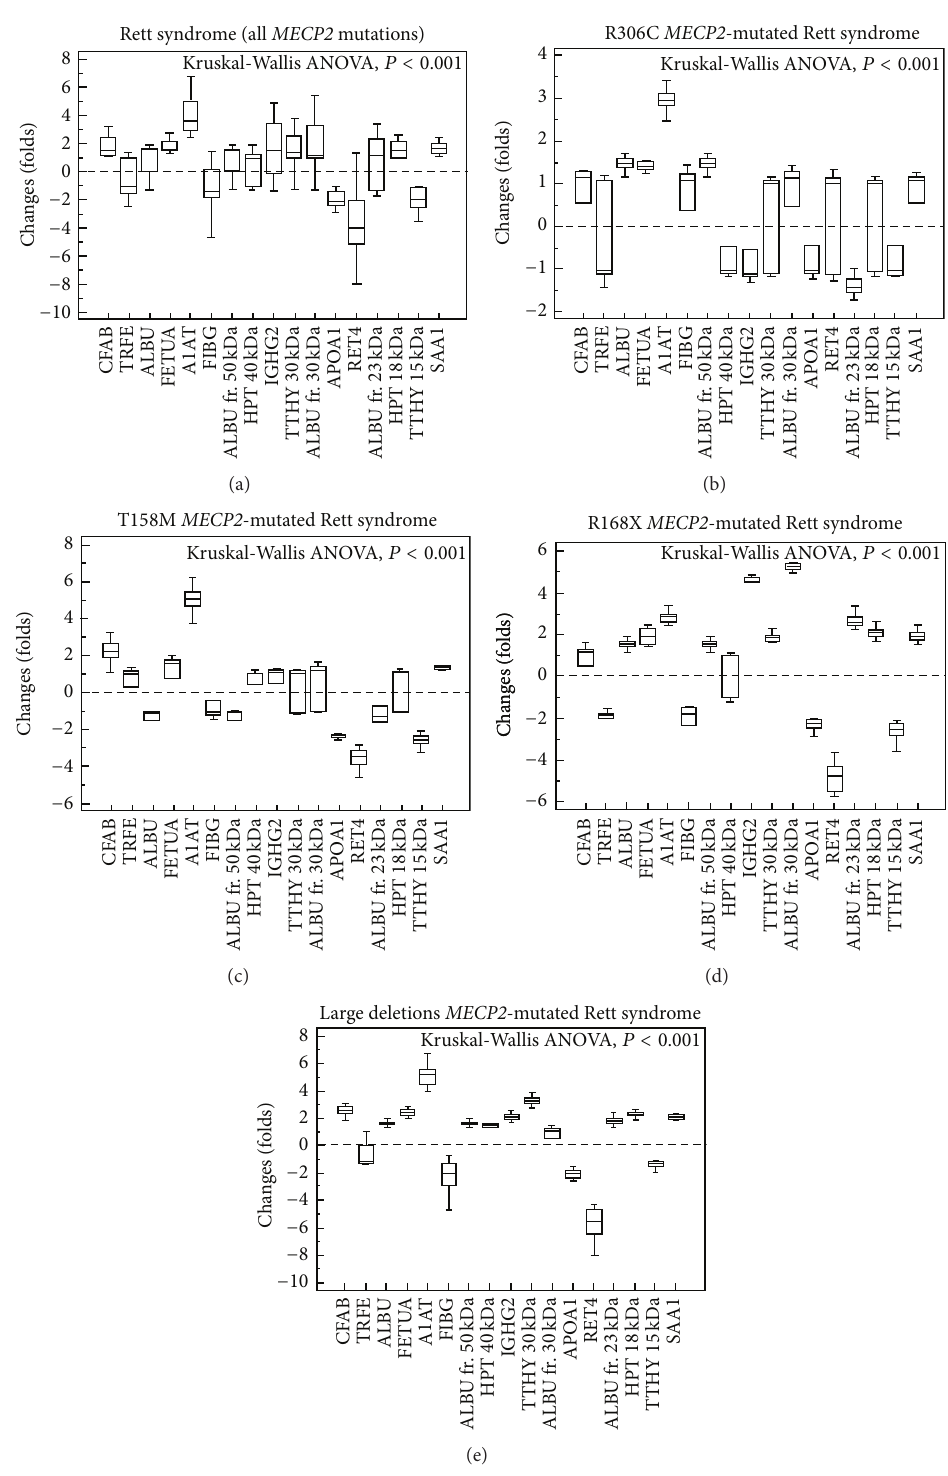
Figure 2: Plasma proteins expression as a function of MECP2 mutations in girls with classical Rett syndrome. (a) All MECP2 mutations, (b) R306C mutation (milder form), (c) T158M mutation (intermediate severity), (d) and (e) correspond to R168X and large deletions (severe forms), respectively. Data are compared to matched healthy controls and expressed as box-and-whiskers plots. Results of Kruskal-Wallis ANOVA are